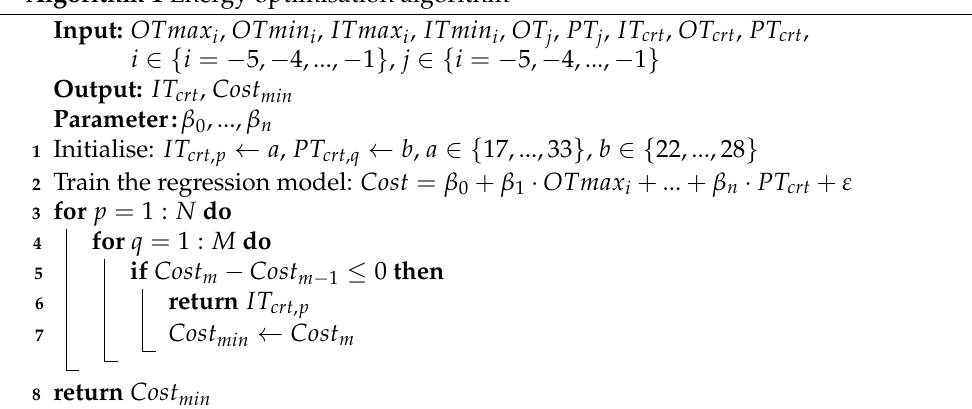
Algorithm 1 Energy optimisation